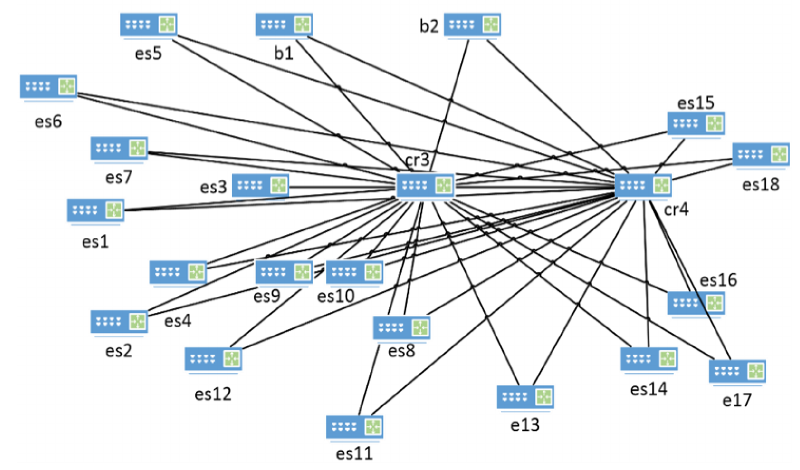
Figure 3. Real data center